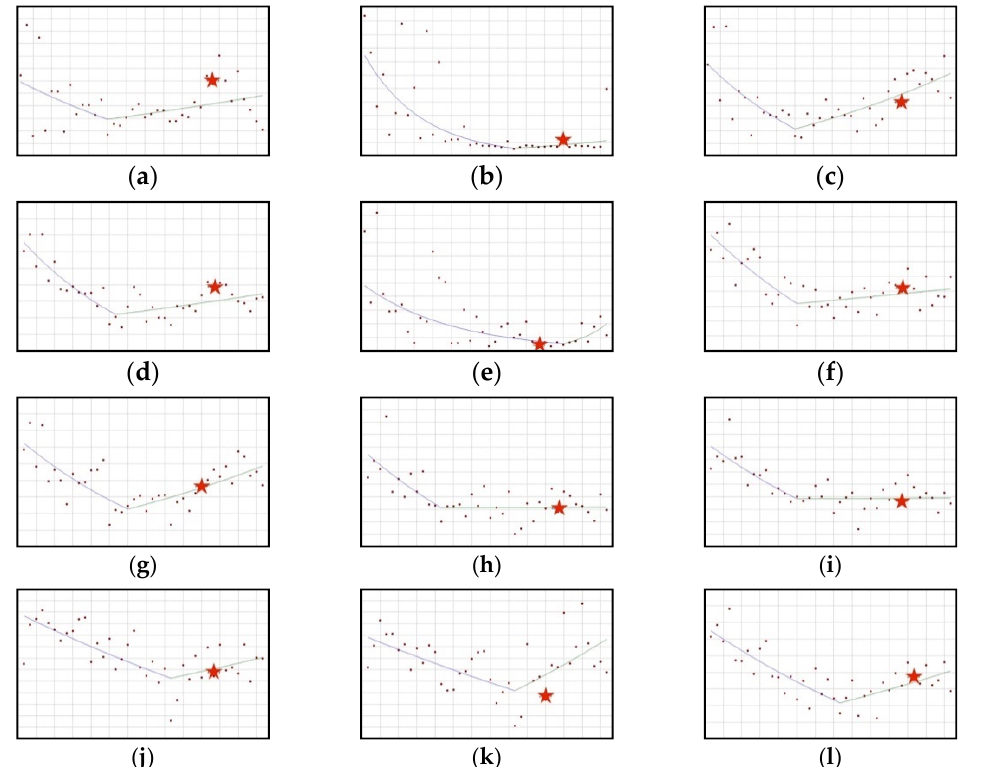
Figure 4. A schematic graph of the frequency of use of the ingredients in the respective quarters in the period from the first quarter of 2012 to the fourth quarter of 2021. The star denotes the moment of publication of a scientific opinion or a resolution concerning the ingredient. The height of placement of the symbol reflects the level of use of the ingredient. ( a ): Copper (Figure A17); ( b ): Fluorine (Figure A18); ( c ): Iodine (Figure A19); ( d ): Iron (Figure A20); ( e ): Isoflavones (Figure A21); ( f ): Magnesium (Figure A22); ( g ): Vitamin A (Figure A23); ( h ): Vitamin B1 (Figure A24); ( i ): Vitamin B2 (Figure A25); ( j ): Vitamin B6 (Figure A26); ( k ): Vitamin C (Figure A27); ( l ): Vitamin E (Figure A28).